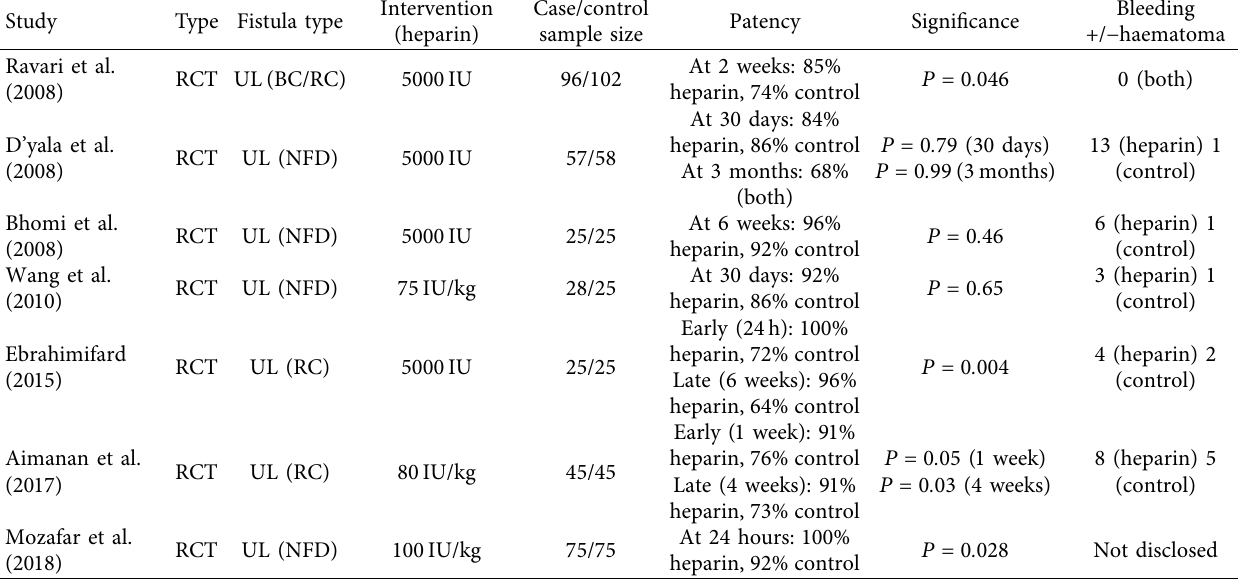
Table 1: Summary of included studies including outcomes for patency and bleeding/haematoma.